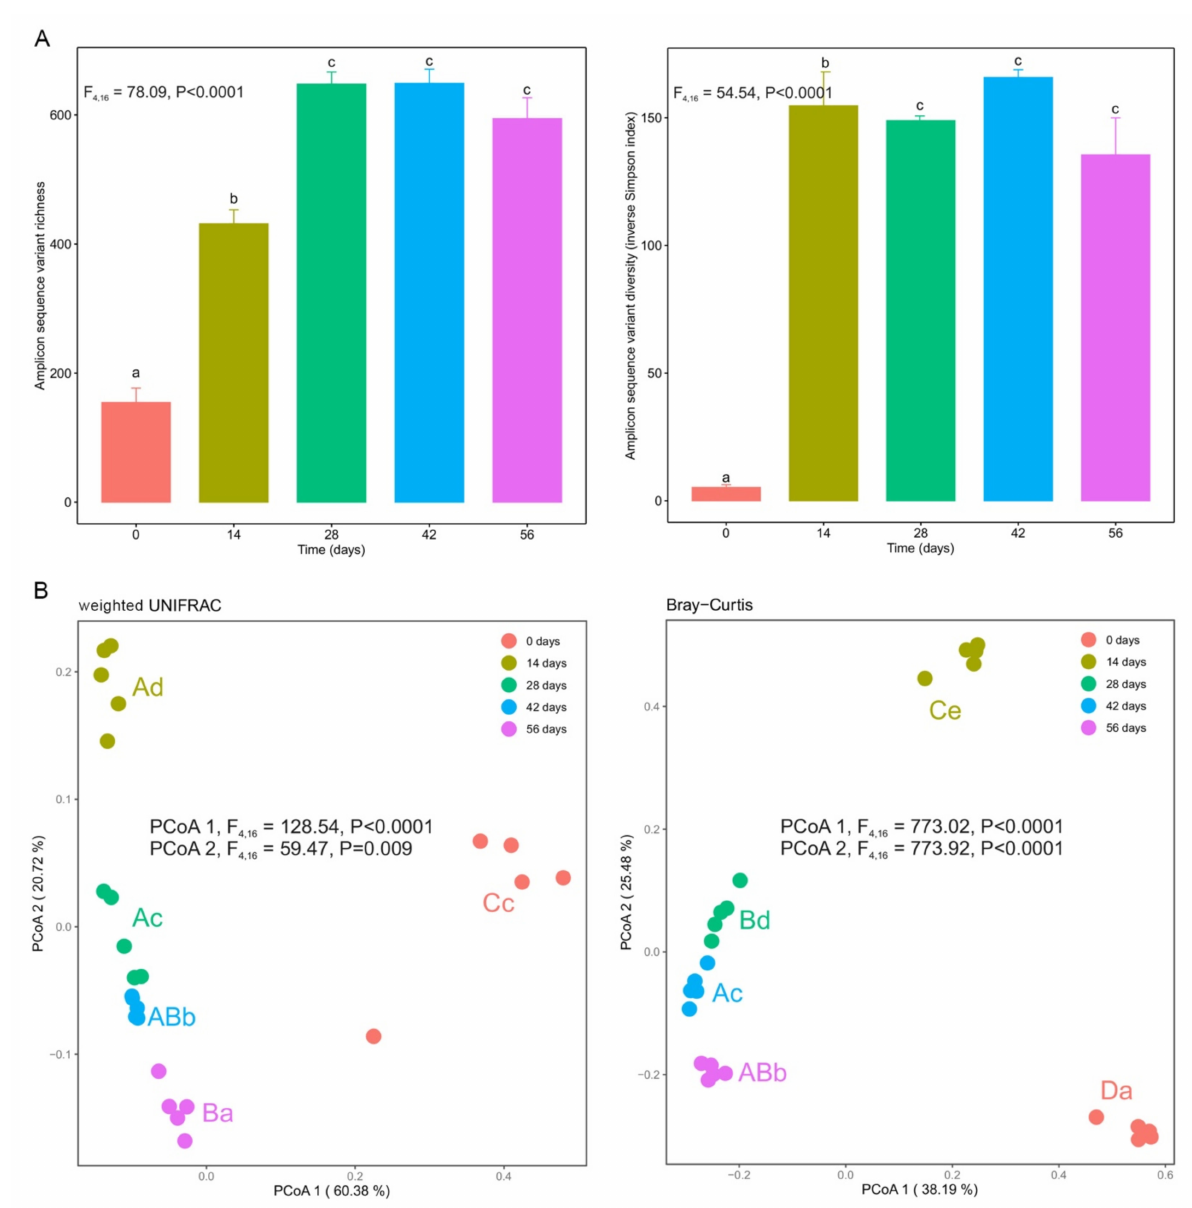
Figure 3. Changes in bacterial α - and β -diversity during vermicomposting of the silver wattle. ( A ) α - diversity is shown in terms of amplicon sequence variant (ASV) taxonomic richness and diversity (inverse Simpson index). Letters indicate significant differences between time points (Tukey HSD test). ( B ) β -diversity is shown with principal coordinate analysis (PCoA) of weighted UniFrac and Bray–Curtis distances. Capital and lower case letters indicate significant differences between the time points in PCoA1 and PCoA2 scores, respectively (Tukey HSD test, FDR